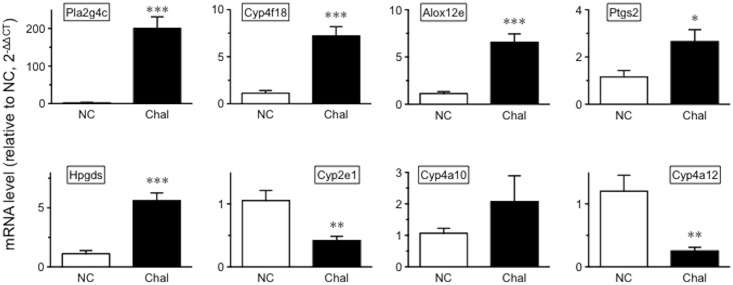
Quantitative RT-PCR validation of differentially expressed genes included in the arachidonic acid metabolism pathway in bronchial smooth muscle tissues of the antigen-challenged mice. Each column represents the mean ± SEM from 6 animals in duplicate, respectively. NC: naive control, and Chal: repeatedly antigen-challenged groups. *P < 0.05, **P < 0.01 and ***P < 0.001 by unpaired Student’s t-test.